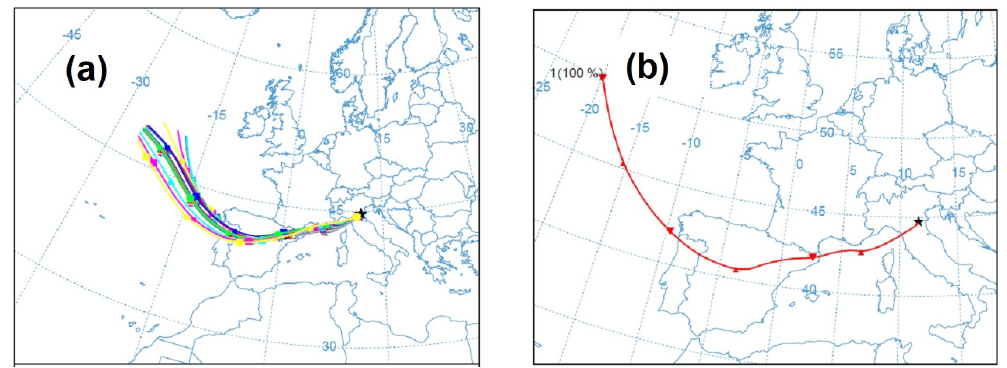
Figure 1. (a) The ensemble of 20 72h back trajectories calculated by HYSPLIT for air parcels arriving at the San Pietro Capofiume site on 8 July 2012 at 03:00LT and (b) the ensemble average trajectory calculated by the HYSPLIT clustering